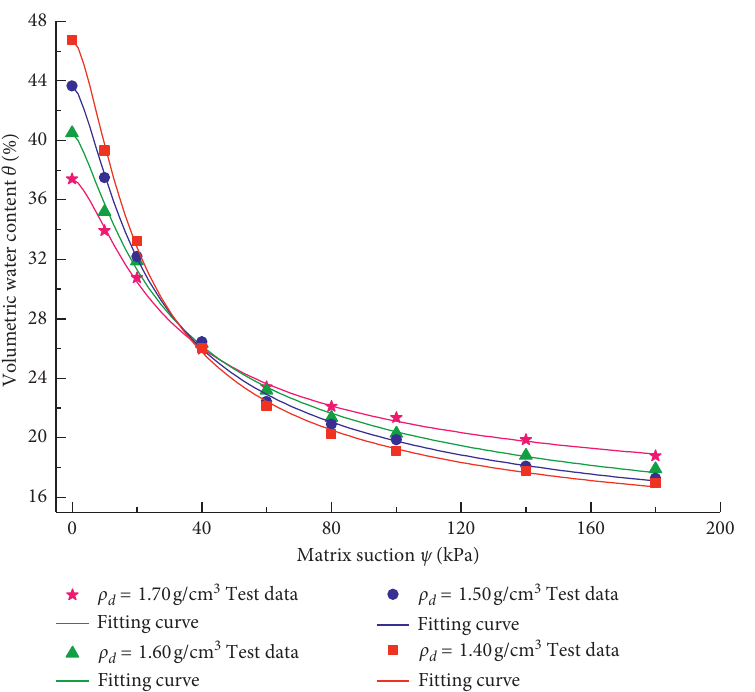
Figure 6: Soil-water characteristic curve fit using the van Genuchten